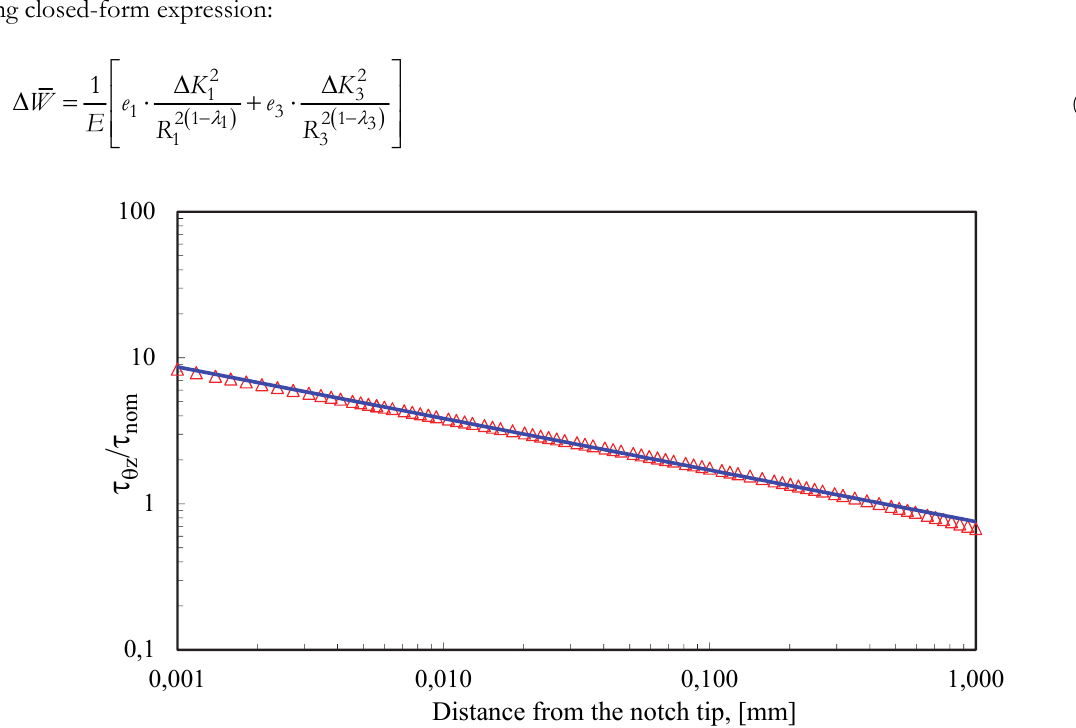
Figure 3: Local shear stress field along the notch bisector line (Mode III